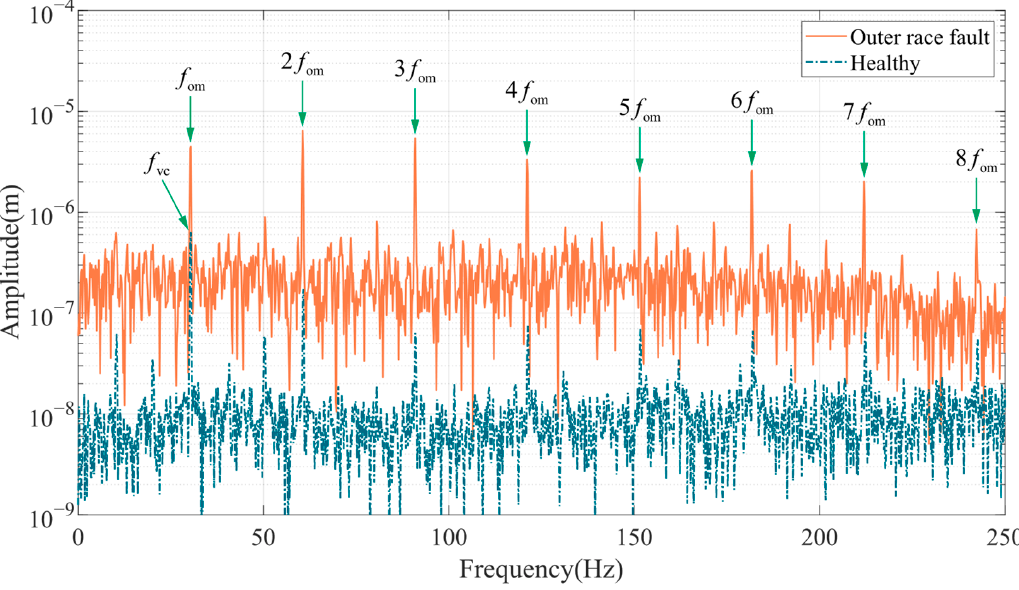
Figure 13. Comparison of rotor vibration spectrum in Y-direction under outer race fault (10 Hz).